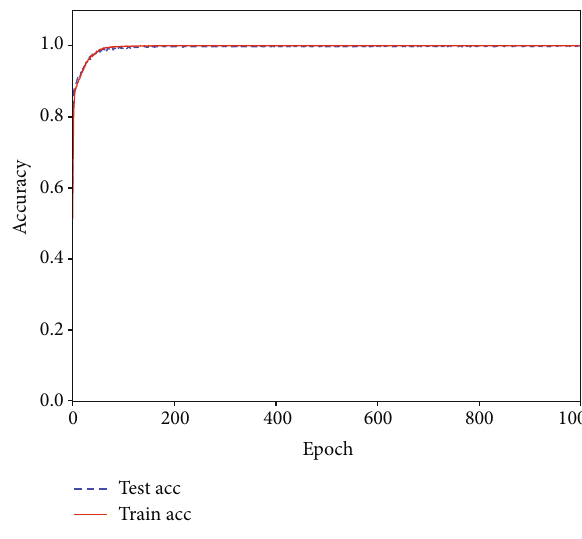
Figure 10: IMFs of no- fl utter